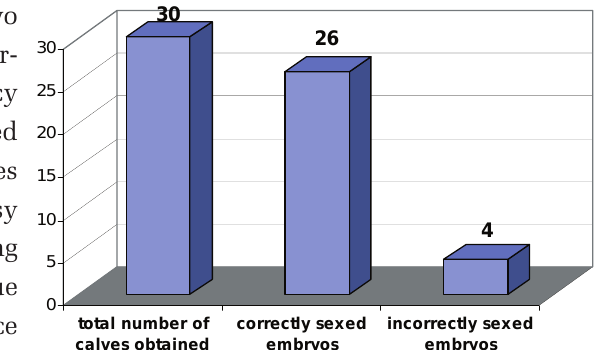
Chart 4. Accuracy of the FISH bovine embryo sexing